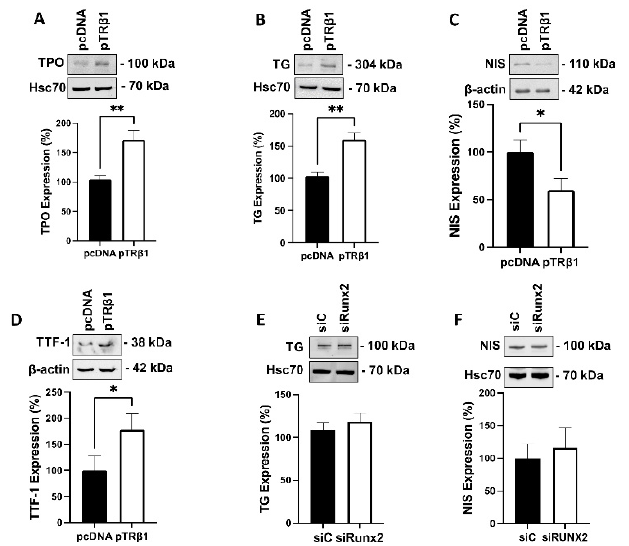
Figure 6. TR β 1 overexpression modulates thyroid specific proteins expression in ML-1 cells. ( A ), The protein expression of thyroperoxidase (TPO) was increased in TR β 1 overexpressing ML-1 cells (pTR β 1), compared to control cells (pcDNA). A representative Western blot is shown. Hsc70 was used as a loading control. The bar diagram shows the mean ± SEM ( n = 3). ** p < 0.01. ( B ), The protein expression of thyroglobulin (TG) was increased in TR β 1 overexpressing ML-1 cells compared to control cells. A representative Western blot is shown. Hsc70 was used as a loading control. The bar diagram shows the mean ± SEM ( n = 3). ** p < 0.01. ( C ), The protein expression of sodium/iodide symporter (NIS) was decreased in TR β 1 overexpressing ML-1 cells compared to control cells. A representative Western blot is shown. b-actin was used as a loading control. The bar diagram shows the mean ± SEM ( n = 3). * p < 0.05. ( D ), The protein expression of thyroid transcription factor 1 (TTF-1) was increased in TR β 1 overexpressing ML-1 cells compared to control cells. A representative Western blot is shown. b-actin was used as a loading control. The bar diagram shows the mean ± SEM ( n = 3). * p < 0.05. ( E ), Silencing Runx2 (siRunx2) had no effect on the protein expression of TG in ML-1 cells. A representative Western blot is shown. Hsc70 was used as a loading control. The bar diagram shows the mean ± SEM ( n = 3). ( F ) Silencing Runx2 had no effect on the protein expression of NIS in ML-1 cells. A representative Western blot is shown. Hsc70 was used as a loading control. The bar diagram shows the mean ± SEM ( n = 3).